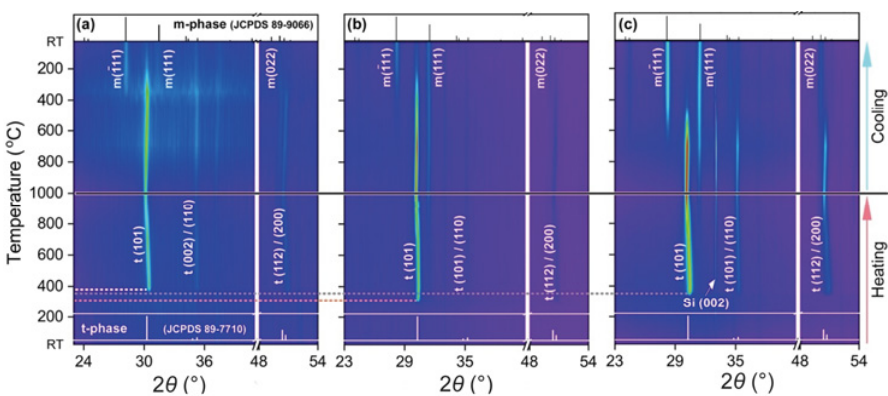
Fig. 2 In-situ high-temperature XRD patterns for samples with thicknesses of (a) 30, (b) 90, and (c) 300 nm, including both heating (from RT to 1000 ) and cooling (from 1000 to RT) processes. References of diffraction patterns of ℃ ℃ m- and t-phases are superposed. The signal located at ~33.2° is assigned to the (002) diffraction peak of Si substrate.